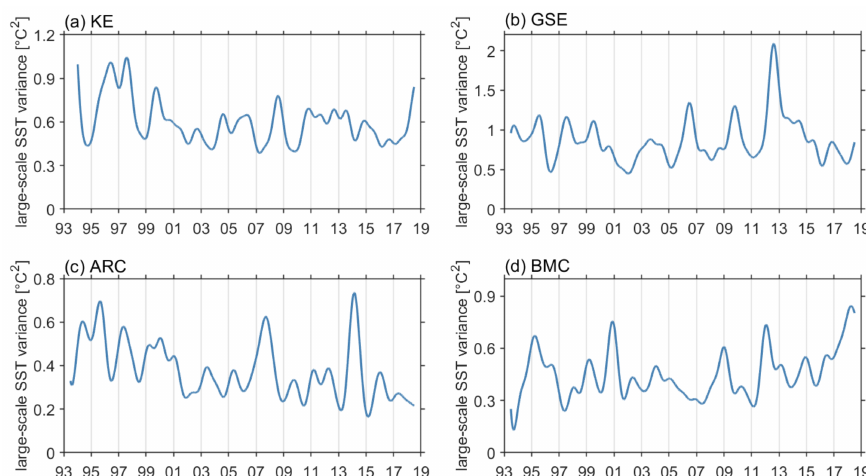
Figure 10. Time series of the 1.5-year low-pass filtered large-scale SST variance in the ( a ) KE, ( b ) GSE, ( c ) ARC, and ( d ) BMC regions based on the OI.v2-AVHRR-only